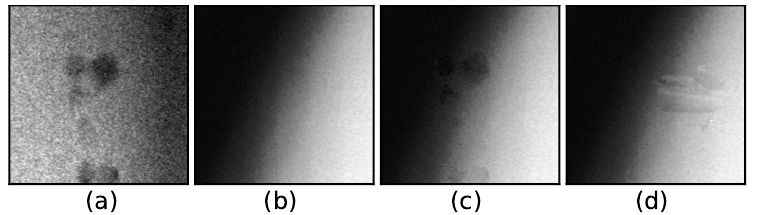
Figure 3. Examples of perturbed defect patches in the training dataset; ( a ) real defect, ( b ) okay weld, ( c ) okay plus real defect patch, and ( d ) okay weld plus a synthetic natural image-based defect patch; ( a – c ) are adapted from [37] with permission from